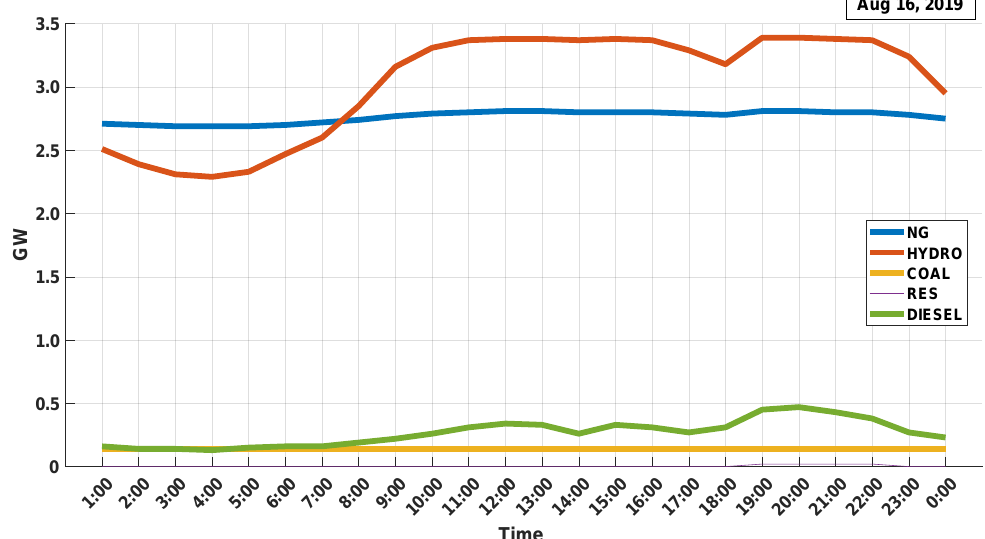
Figure 10. Contribution to the dispatch by type of technology—stage 1.